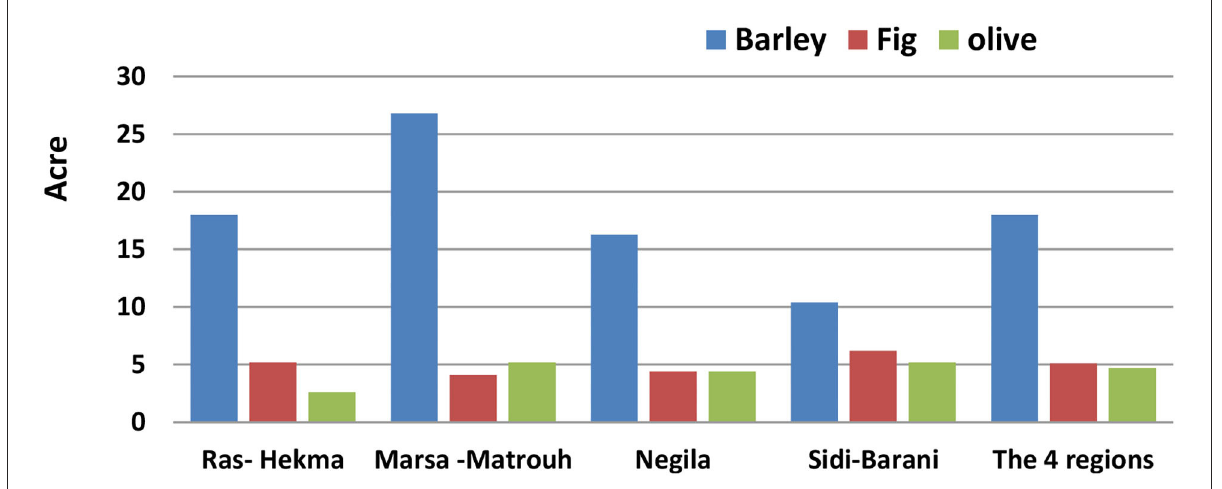
FIGURE2 Average areas for the main crops/household in the studied locations (151